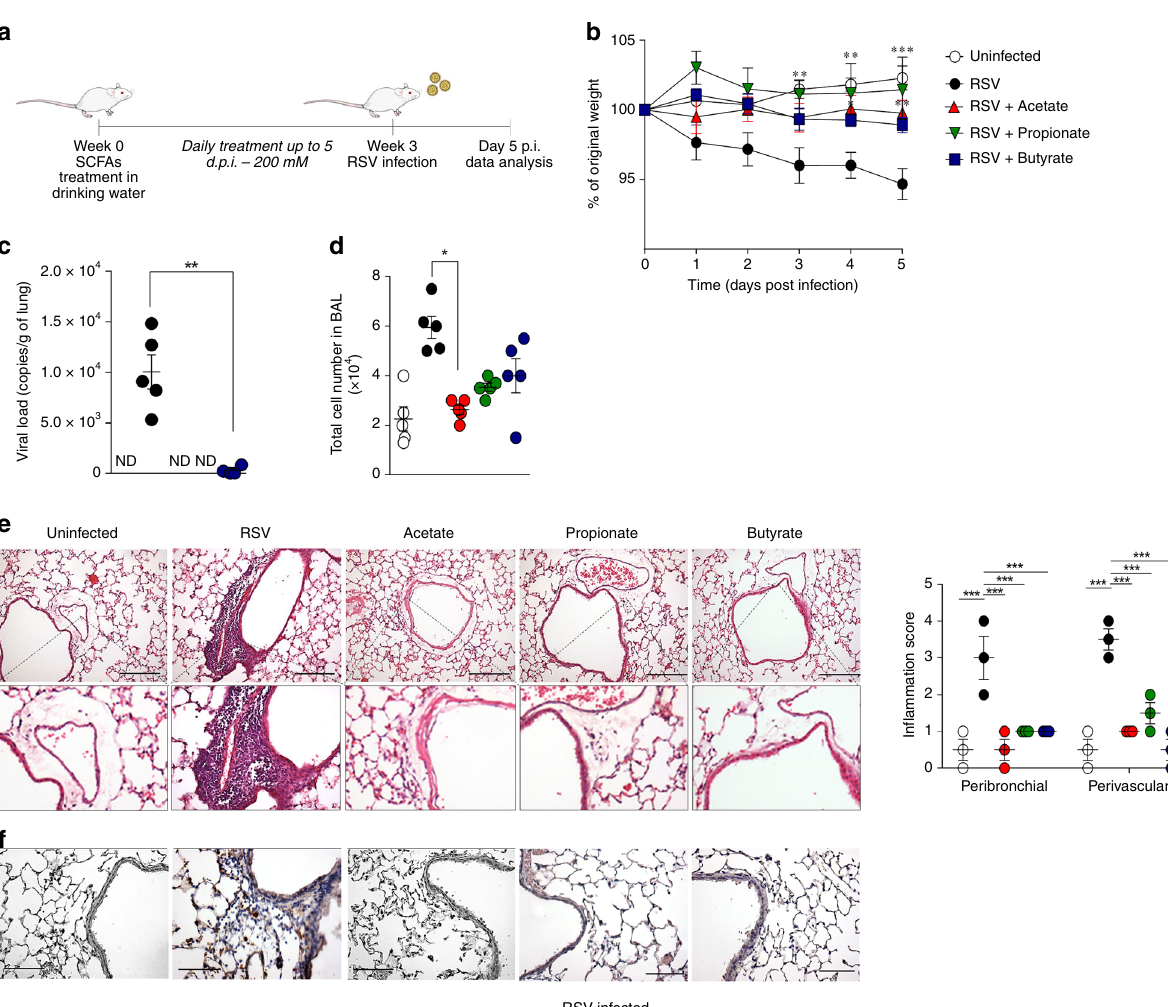
Fig. 3 SCFAs pre-treatment protects mice against RSV infection. a BALB/c mice were given, sodium acetate, sodium propionate or sodium butyrate in sterile drinking water at a fi nal concentration of 200 mM for 3 weeks before and during RSV infection. Analyses were performed on day fi ve post infection. b Percentage body weight loss post infection relative to initial weight (day 0) ( n = 5). c RSV viral load detected in lung tissue by real-time PCR ( n = 5). d Total cell number in BALF ( n = 5). E, Representative hematoxylin and eosin (H&E)-stained lung tissue images and its respective in fl ammation score. Scale bars = 100 μ m. f Immunohistochemical (IHC) staining using an anti-RSV Fusion Protein antibody. Scale bars 200 μ m. The results are expressed as mean ± SEM. ND not detected. Statistical signi fi cance between the groups was determined by Kruskal – Wallis, except in c , in which Mann – Whitney was used to compare the groups. * p < 0.05, ** p < 0.01, *** p < 0.001. Data in b – d are provided as a Source Data